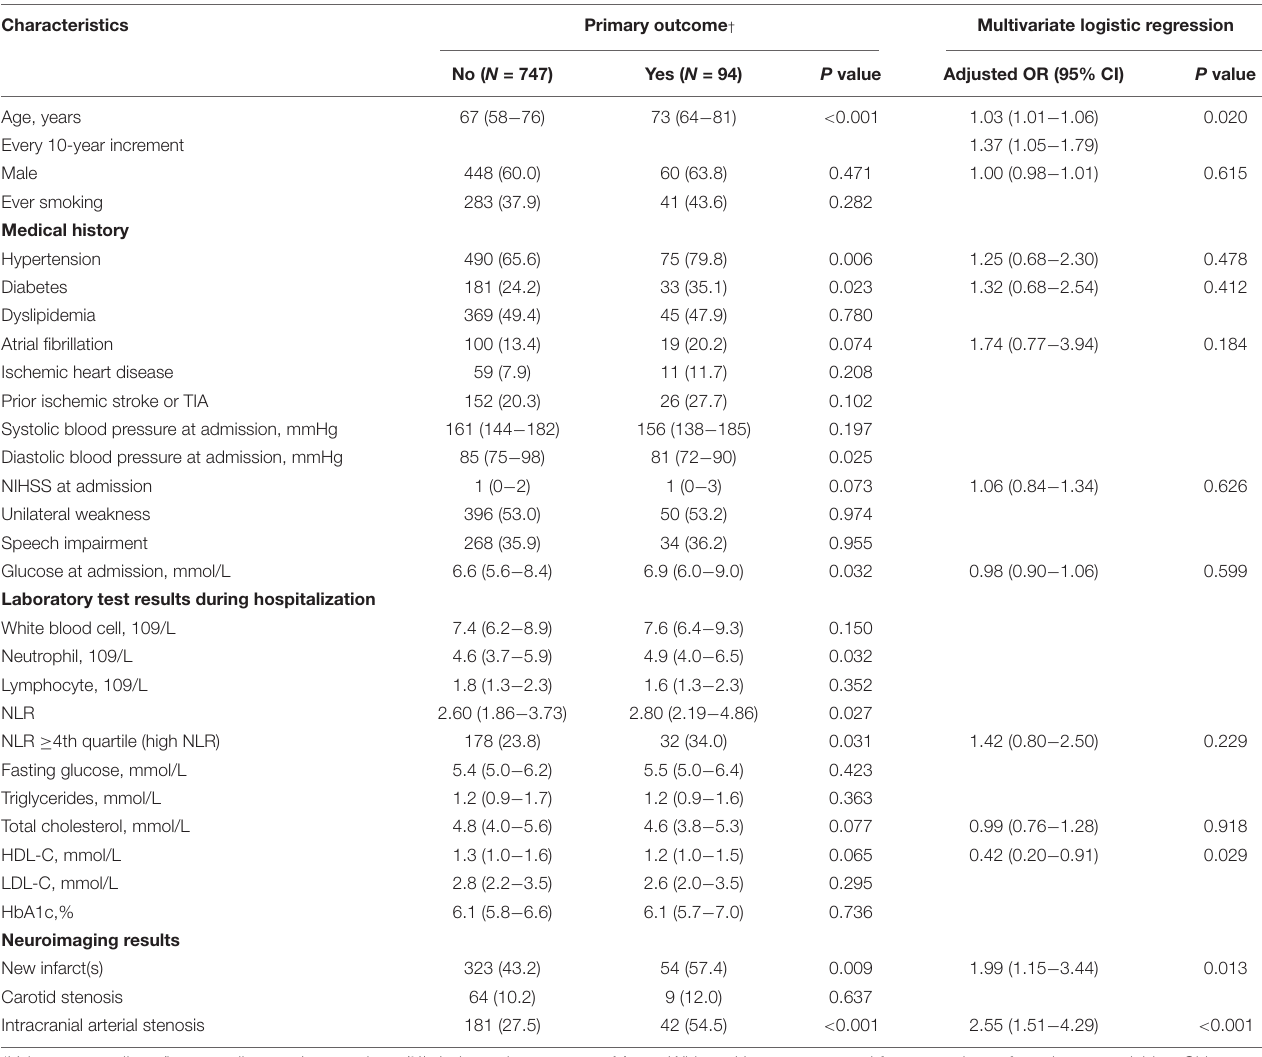
TABLE 2 | Predictors of the primary outcome among all patients *. Characteristics Primary outcome † Multivariate logistic